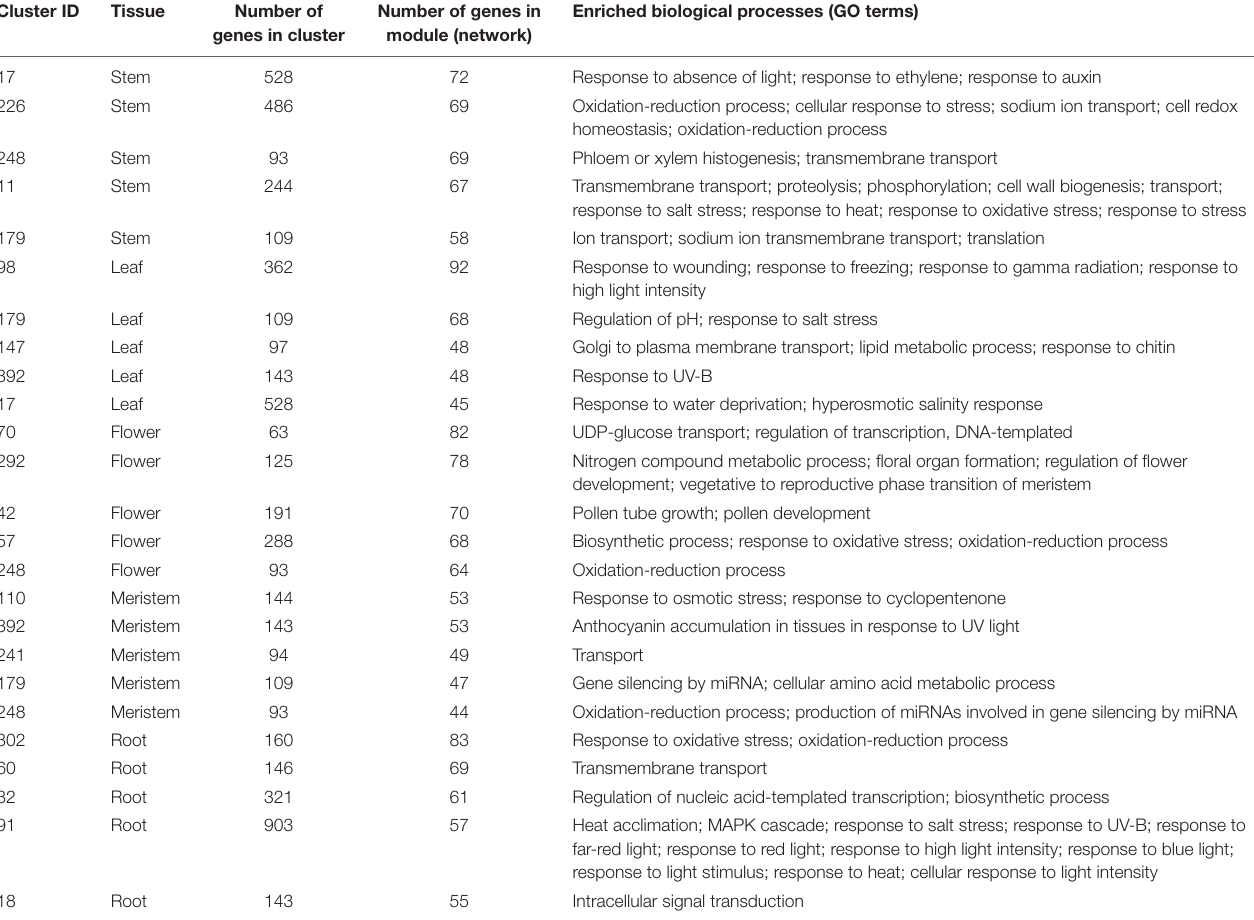
The GO terms shown here were selected based on the climate differences between sampling